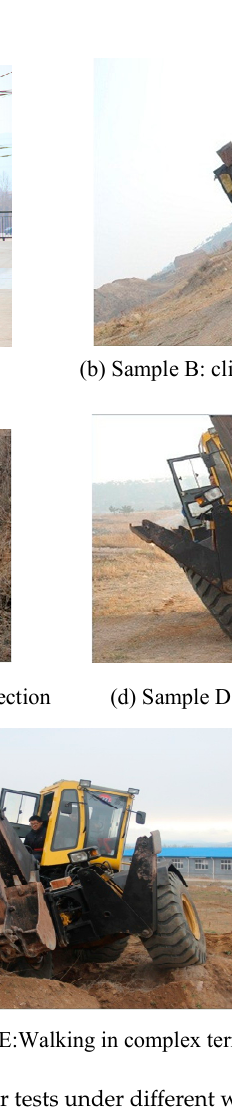
Figure 10. Five sets of rollover tests under different working conditions. Table 3. Monitoring parameter values and ontology-based analysis results.